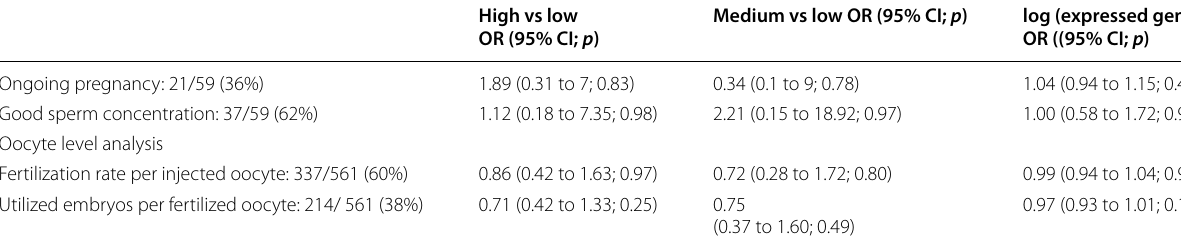
Table 3 Effect of gene expression level on ICSI outcome in patients positive for testicular sperm